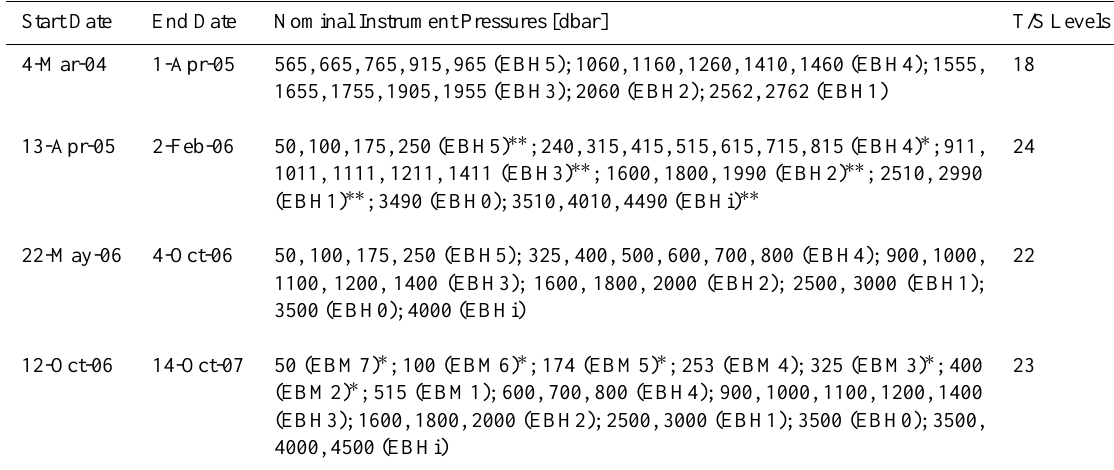
Table 3. Periods of mooring records and nominal pressure levels of sensors of EBH